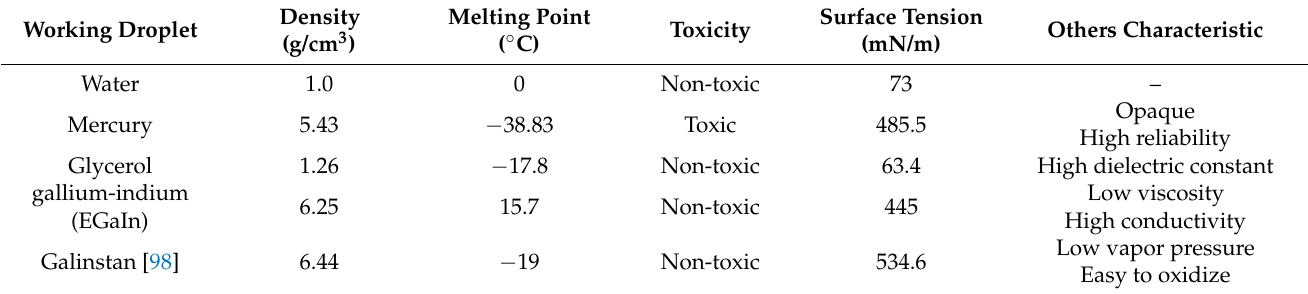
Table 5. Characteristics of some droplets in microfluidic switches.